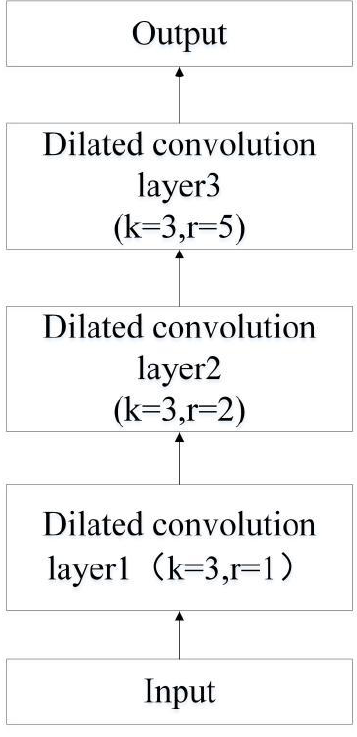
Figure 8. Dilated convolution block.